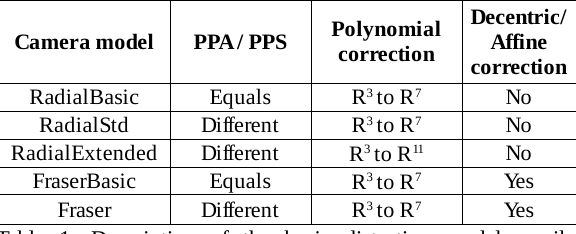
Table 2: Evolution of the reprojection error according to the camera model (working only with the vertical images). The table shows that, for the camera tested, a combination of extended camera models is